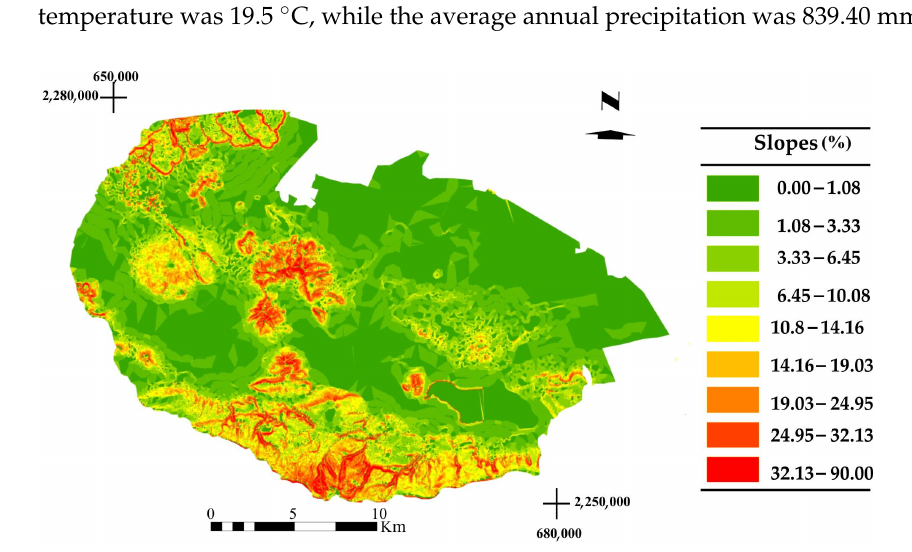
Figure 2. Slopes of the soils of the municipality of Tlajomulco de Zúñiga, Jalisco.